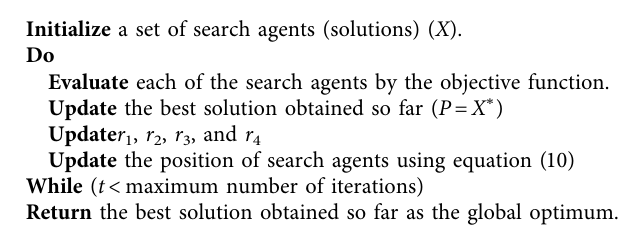
Initialize a set of search agents (solutions) ( X